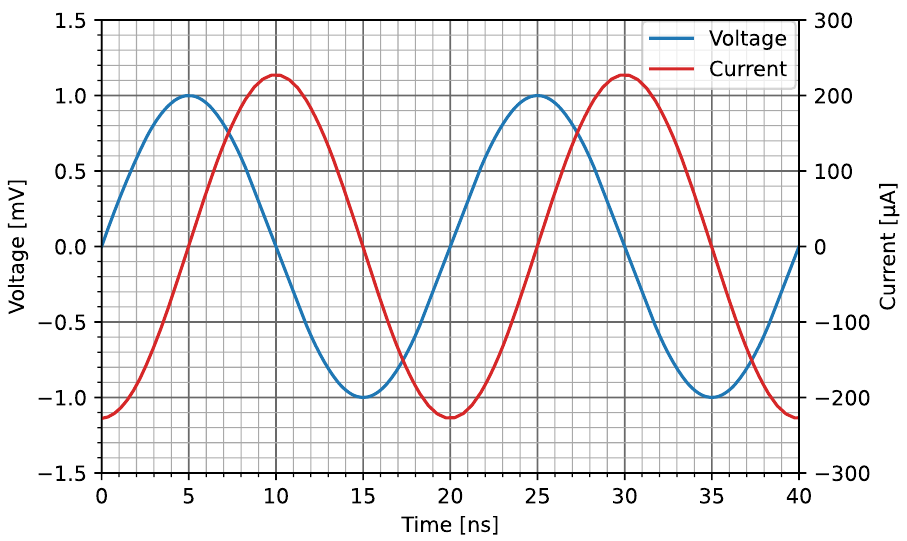
Figure 30. LTspice simulated voltage and current plots for an input signal of 1 mV at 50 MHz.